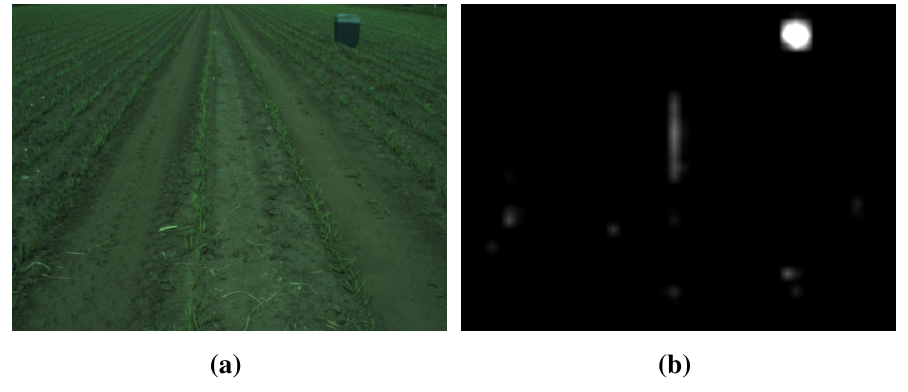
Figure 4. Example of visual saliency in captured data. ( a ) Input RGB color image; ( b ) resulting saliency